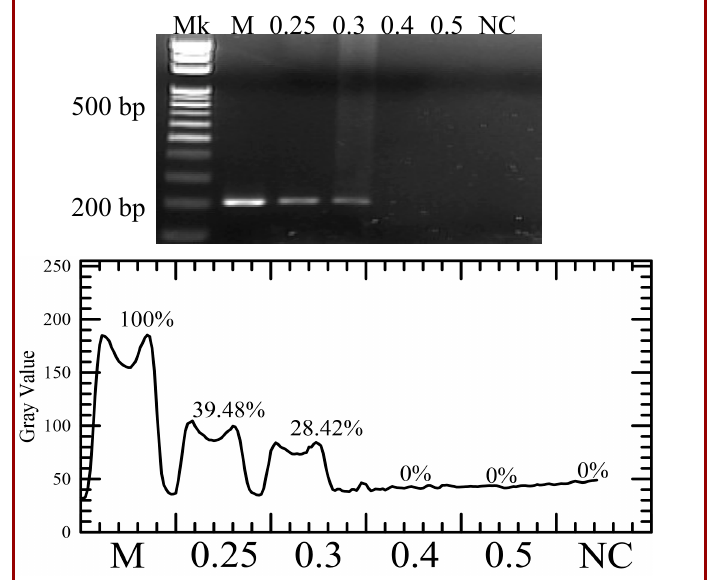
Figure 12. Agarose gel electrophoresis of the polymerase chain reaction (PCR) yield with various flow rates (Lanes 0.25, 0.3, 0.4, and 5). The grey intensities of PCR products are created by image analysis.